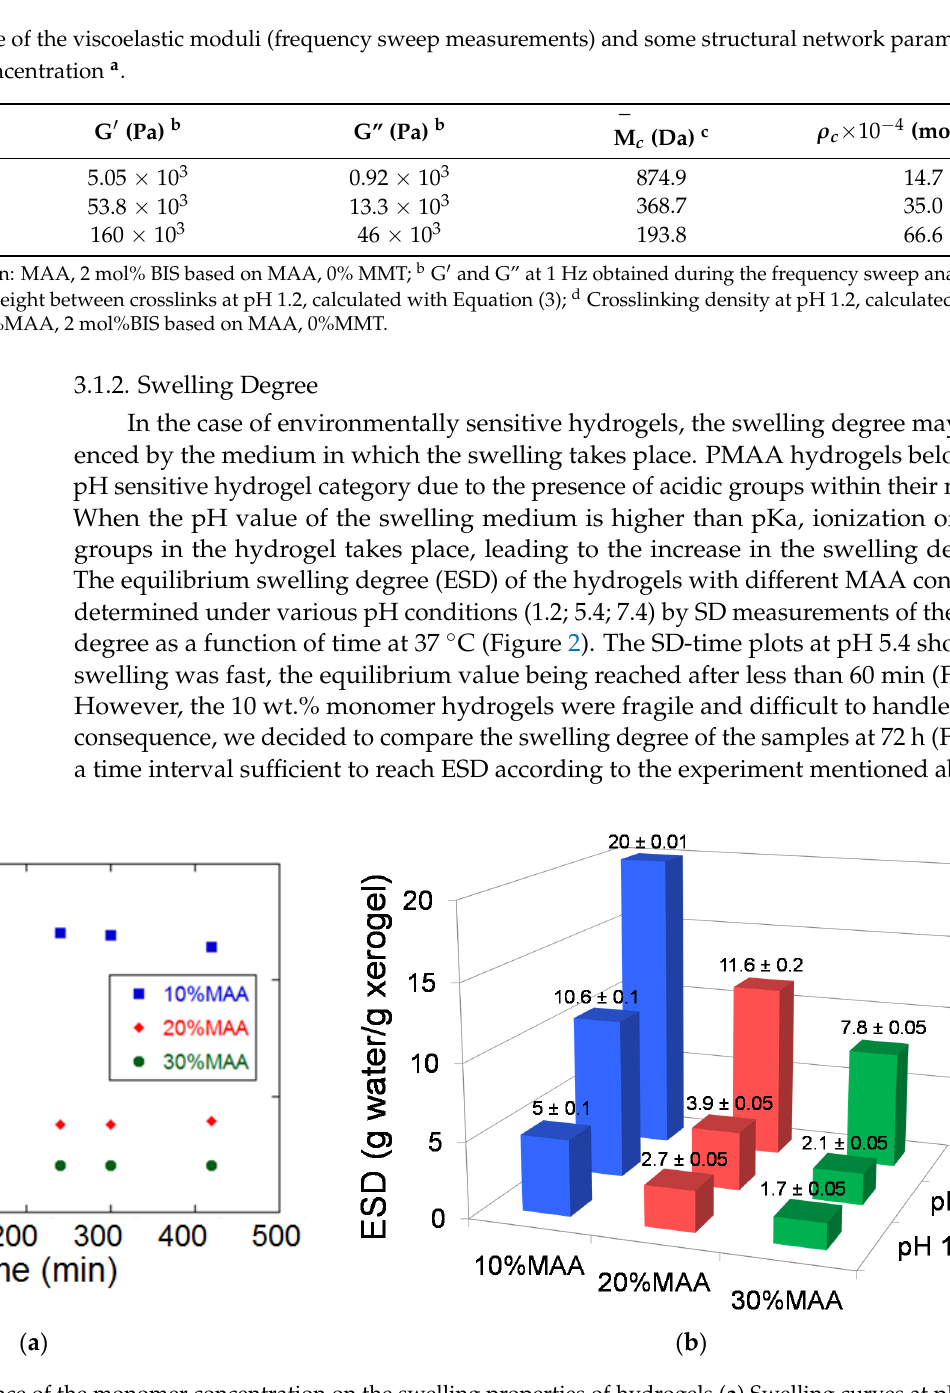
Figure 2. The influence of the monomer concentration on the swelling properties of hydrogels ( a ) Swelling curves at pH 5.4; ( b ) The effect of the monomer concentration on the swelling degree (72 h) at different pH values (1.2; 5.4; 7.4). The results express average values ± standard errors. Hydrogel composition: MAA, 2 mol% BIS based on MAA, 0% MMT.